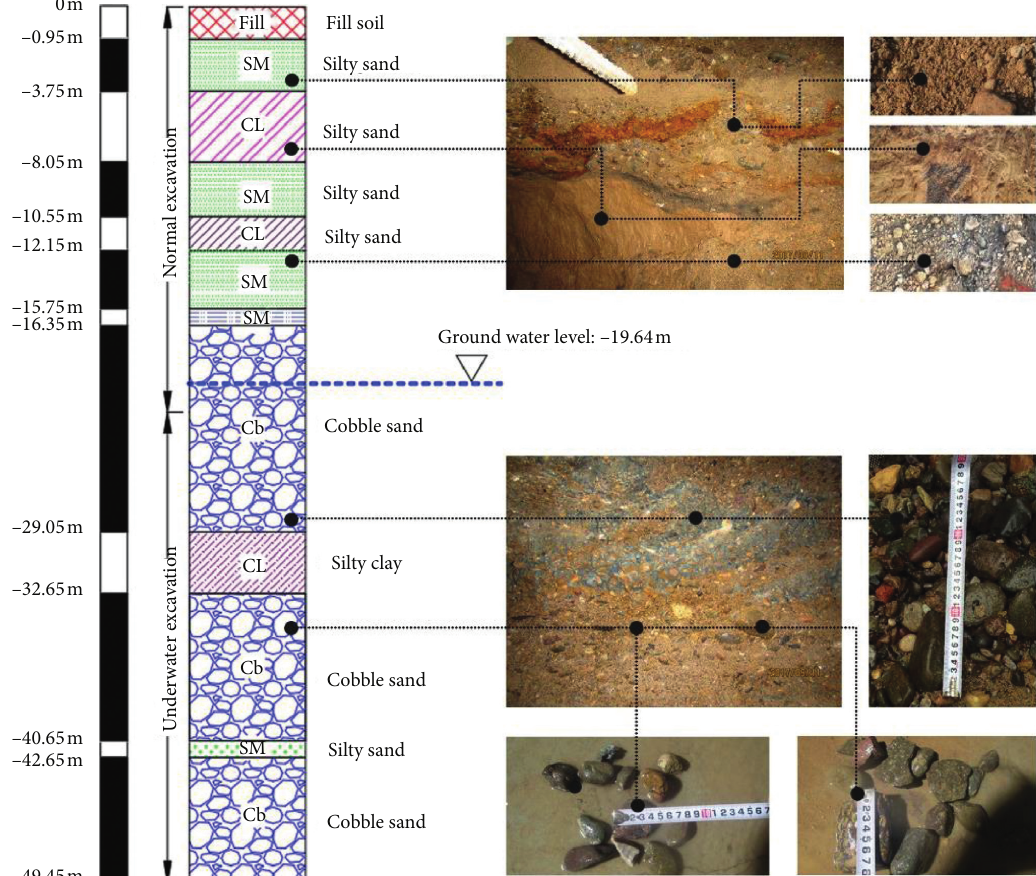
Figure 1: Stratigraphic profile of YDM